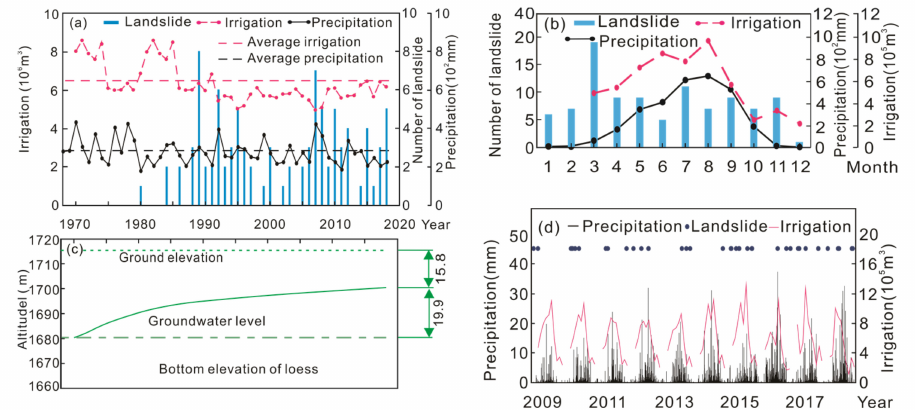
Figure 5. Statistical charts of precipitation, irrigation, groundwater level, and landslide; ( a , c ) charts of interannual variety from 1968 to 2018; ( b ) chart of inter-monthly variation; ( d ) diagram chart of precipitation, irrigation, and landslide from 2009 to